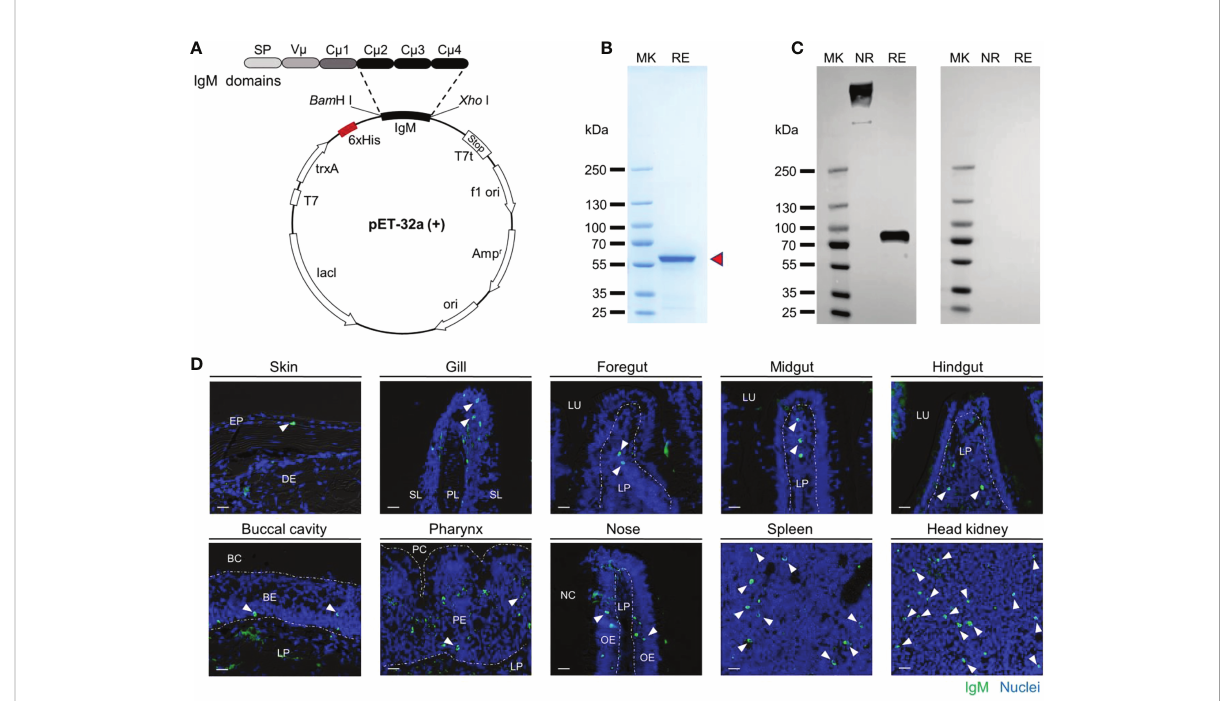
FIGURE 1 The common carp IgM polyclonal antibody (pAb) production and characterization. (A) Structural schematic of pET-32a-IgM recombinant plasmids. (B) Coomassie blue staining of recombinant protein of IgM resolved by SDS-PAGE. Red arrowheads indicate the recombinant IgM. (C) Western blot analysis with pAb to common carp serum. Left margin, molecular size in kilodaltons (kDa). MK, marker; NR, nonreducing conditions; RE, reducing conditions. (D) Immuno fl uorescence staining of IgM + B cells in different tissues of common carp. Tissue paraf fi nic sections were stained with rabbit anti-carp IgM (green) and nuclei were stained with DAPI (blue) (isotype-matched control antibody staining, Figure S1A). White arrowheads point to cells stained for IgM. White dotted lines outline the border. Scale bar, 20 m m. EP, epidermis; DE, dermis; PL, primary lamella; SL, secondary lamella; LU, lumen; LP, lamina propria; BC, buccal cavity; BE, buccal epithelium; PC, pharyngeal cavity; PE, pharyngeal epithelium; NC, nasal cavity; OE, olfactory